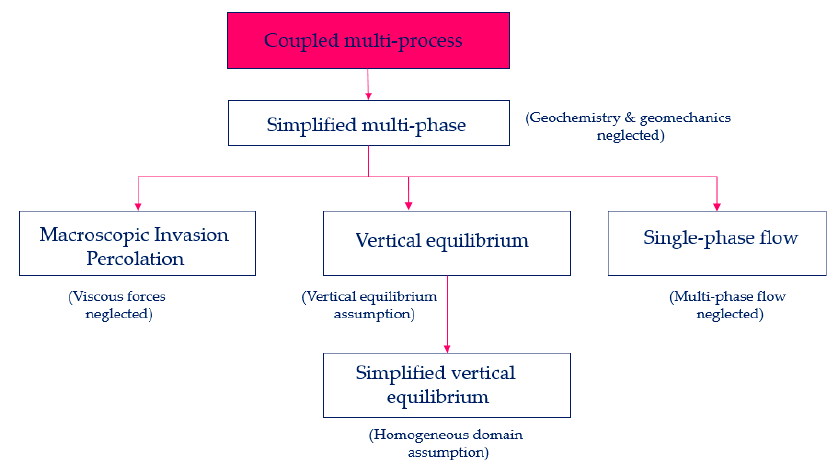
Figure 6. Hierarchy of model complexity (modified after [144]).